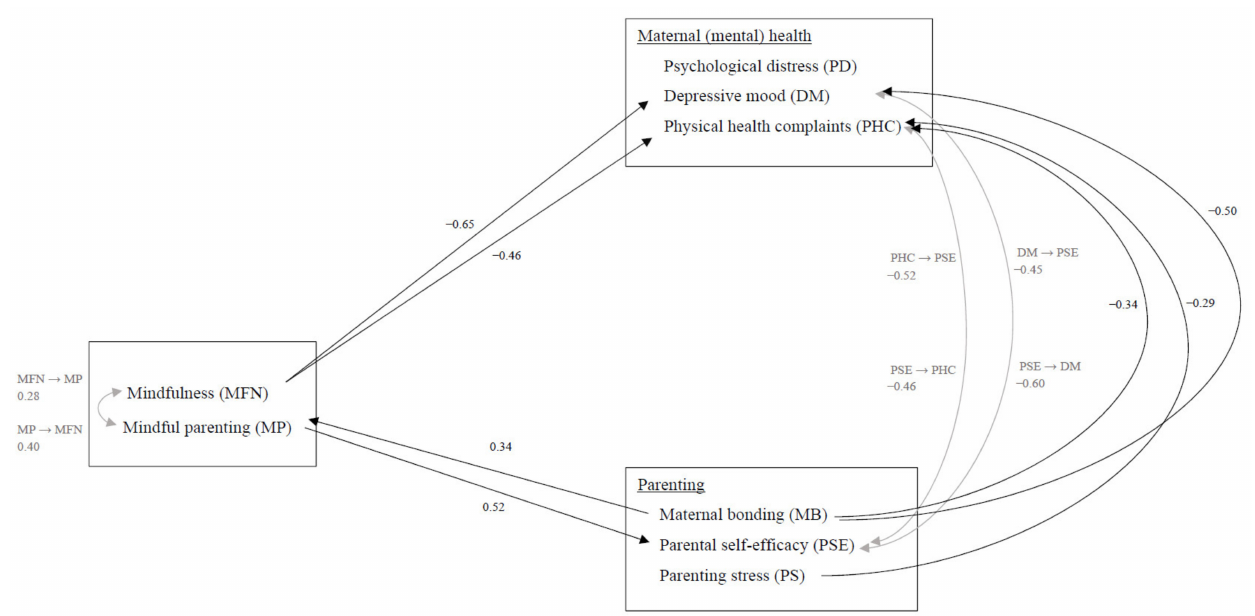
Figure 3. Visual representation of the predictors of treatment outcomes with effect sizes (grey lines for bidirectional